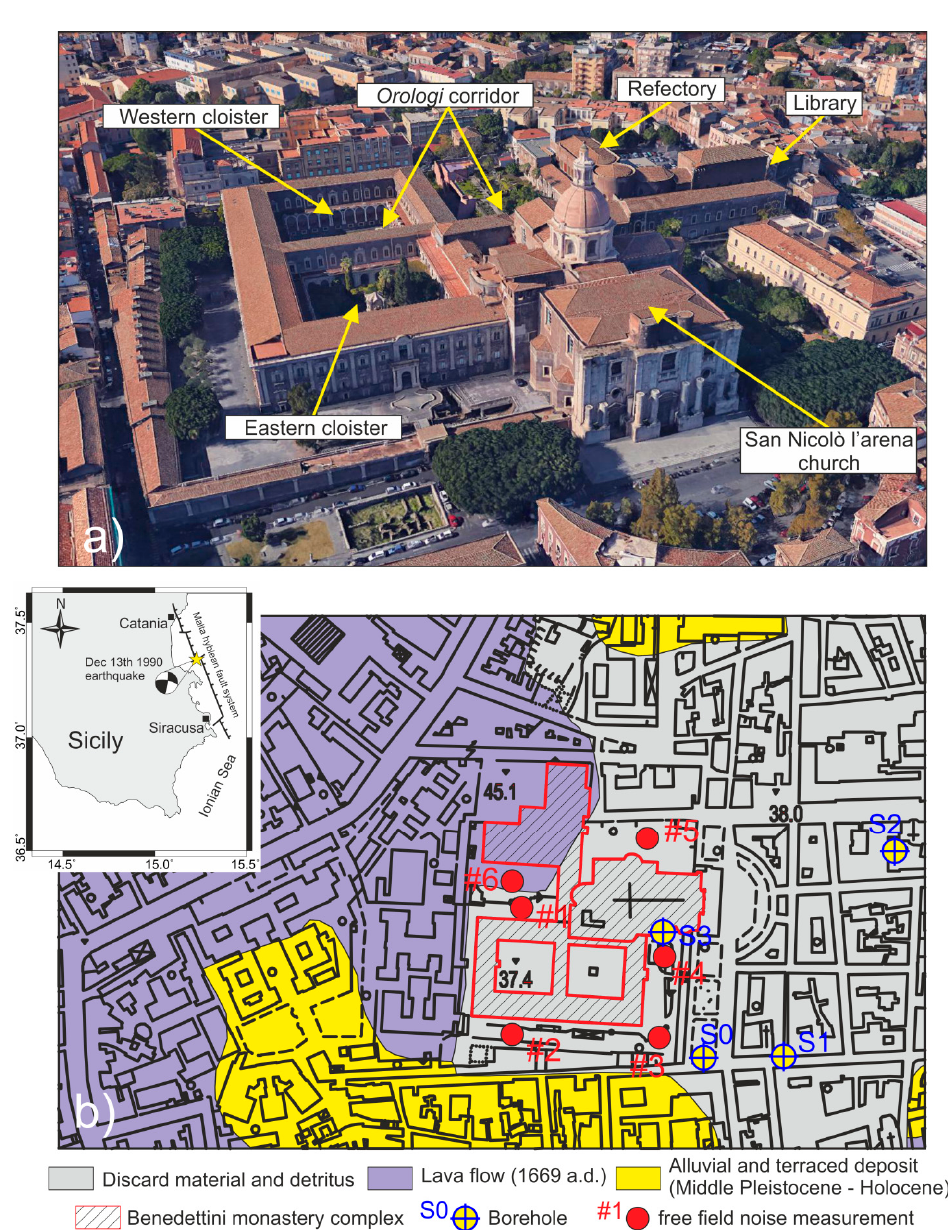
Figure 1. Aerial view ( a ) and lithological sketch ( b ) of the investigated area. The inset shows the location and focal mechanism of the 1990 M5.7 earthquake.